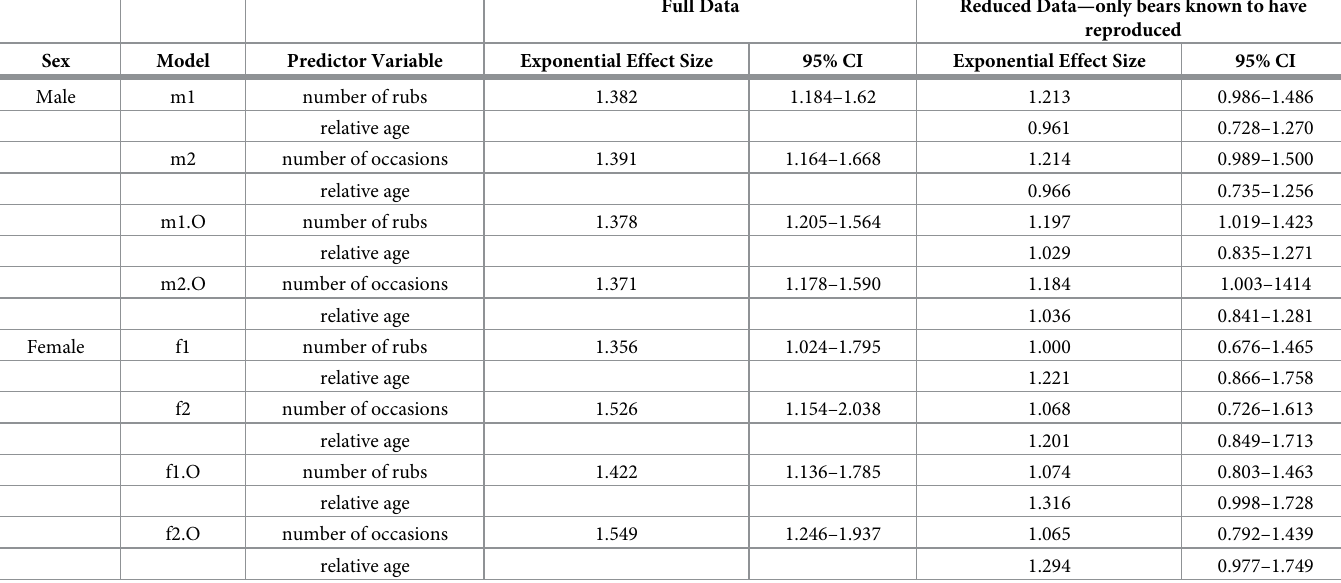
Table 2. Effect sizes for predictor variables of Poisson regression models. Data are from southwestern Alberta 2011–2014.